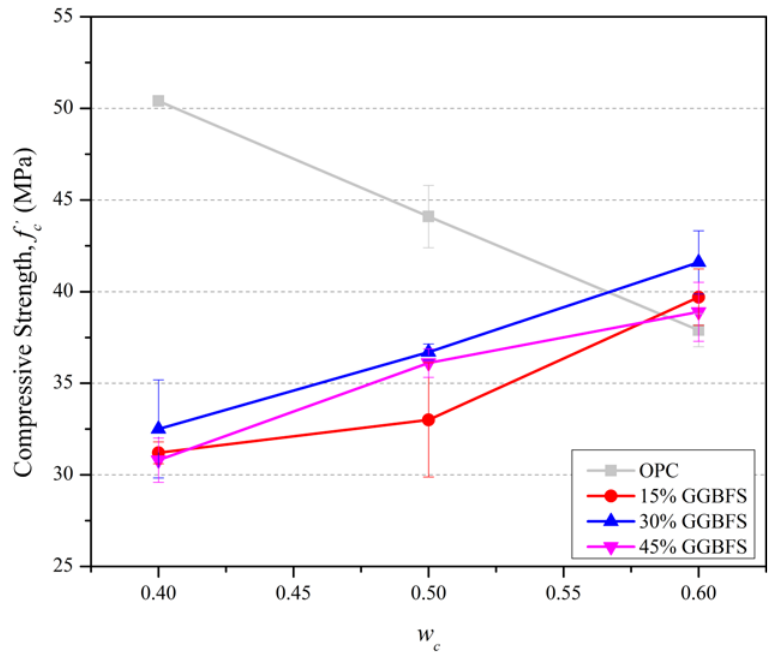
at 28 days. Figure 2. Influence of water content on f (cid:48) c at 28 𝑐𝑐′ 𝑓𝑓